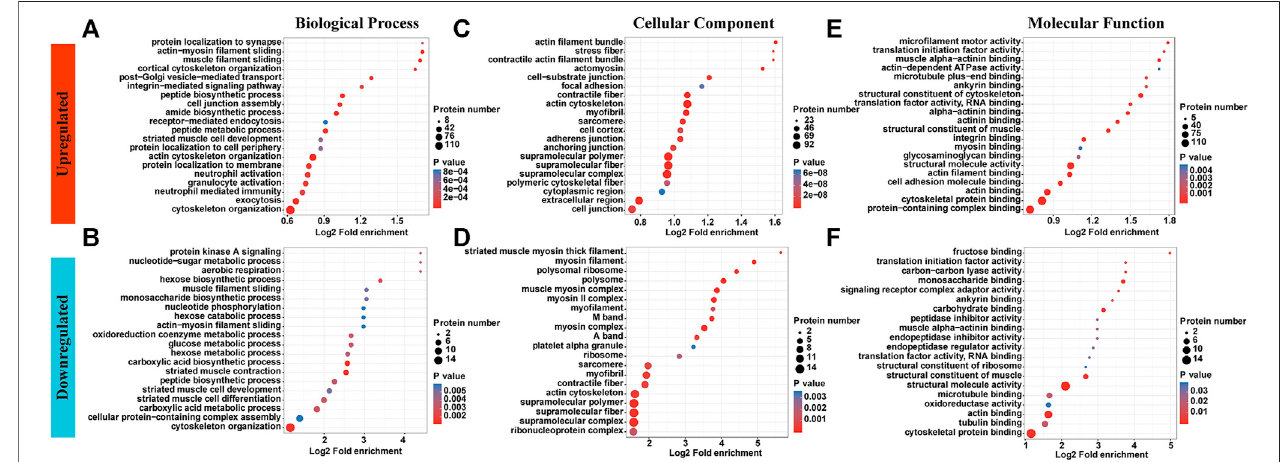
FIGURE2| GOenrichmentanalysesshoweddifferentenrichmentpatternsacrosstwogroups. (A,B) Upregulatedp-siteproteinswerehighlyenrichedinneutrophil or granulocyte activation, and neutrophil-mediated immunity. While proteins were enriched in muscle fi lament sliding, muscle cell development and differentiation showed decreased levels of phosphorylation. (C,D) Most proteins identi fi ed are tendon/muscle assemblies, be those with increased phosphorated p-sites or with decreased p-sites. (E,F) With respect to molecular function, a signi fi cant enrichment in integrin binding was witnessed for upregulated p-site proteins. In addition, the rest are enriched in basic muscle/tendon